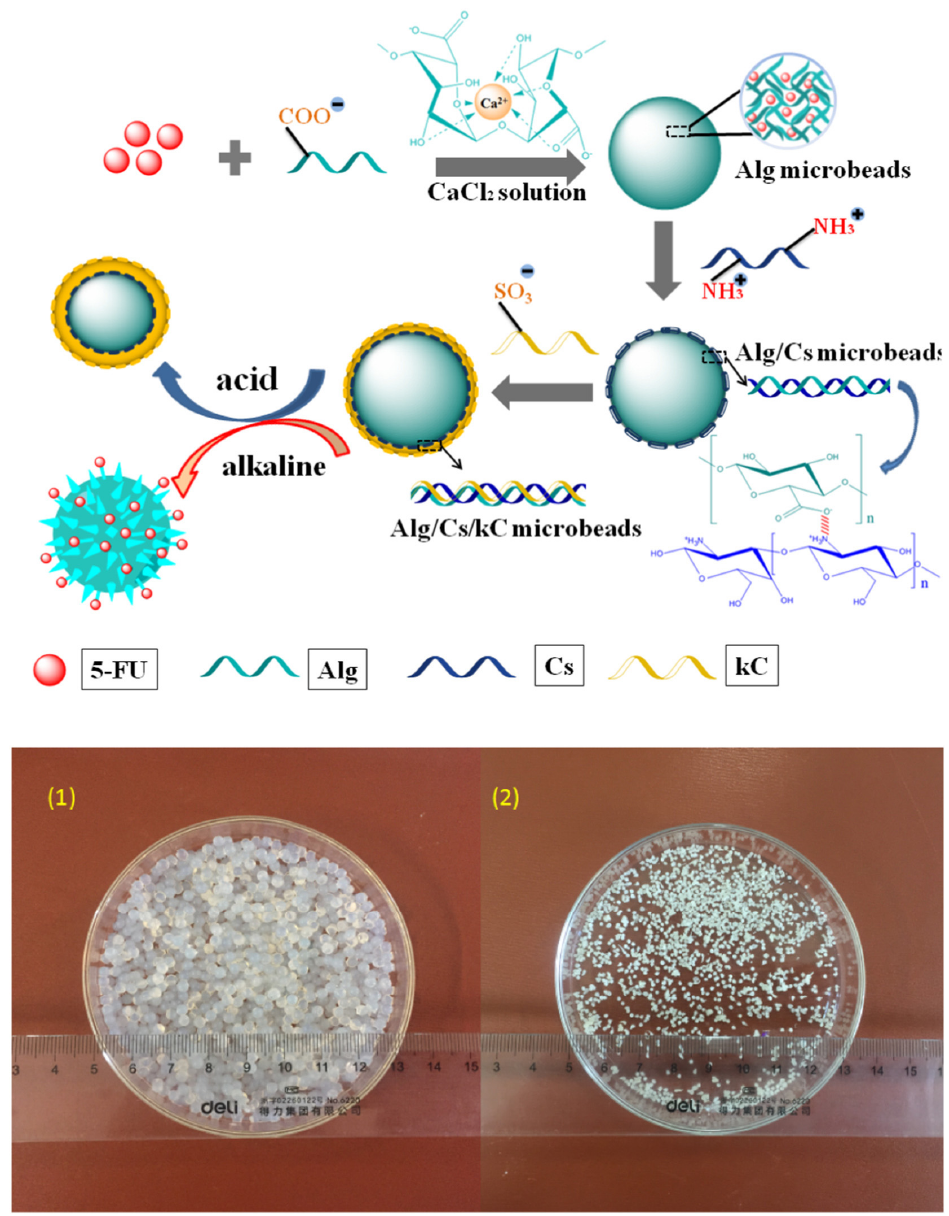
Figure 8. Scheme for the preparation of 5-fluorouracil-loaded alginate (Alg) microbeads with a chitosan (Cs) and carrageenan (kC) coating, and digital photographs of freshly prepared ( 1 ) wet and ( 2 ) dry microbeads. Reproduced from [99] with permission.